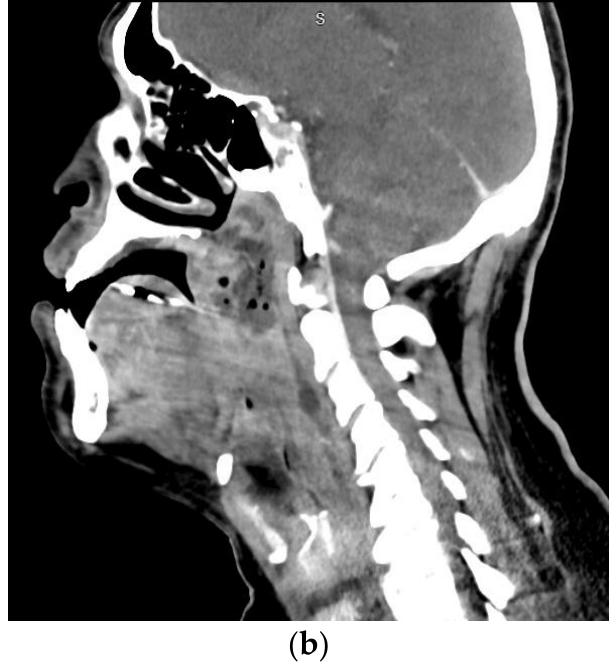
Figure 3. Axial ( a ) and sagittal ( b ) computed tomography scan views of a patient with a left parapharyngeal space infection with significant gas formation. Air and fluid extended within the retropharyngeal space to the level of C6/7. Bacteremia was present, with blood cultures positive for Streptococcus anginosus.